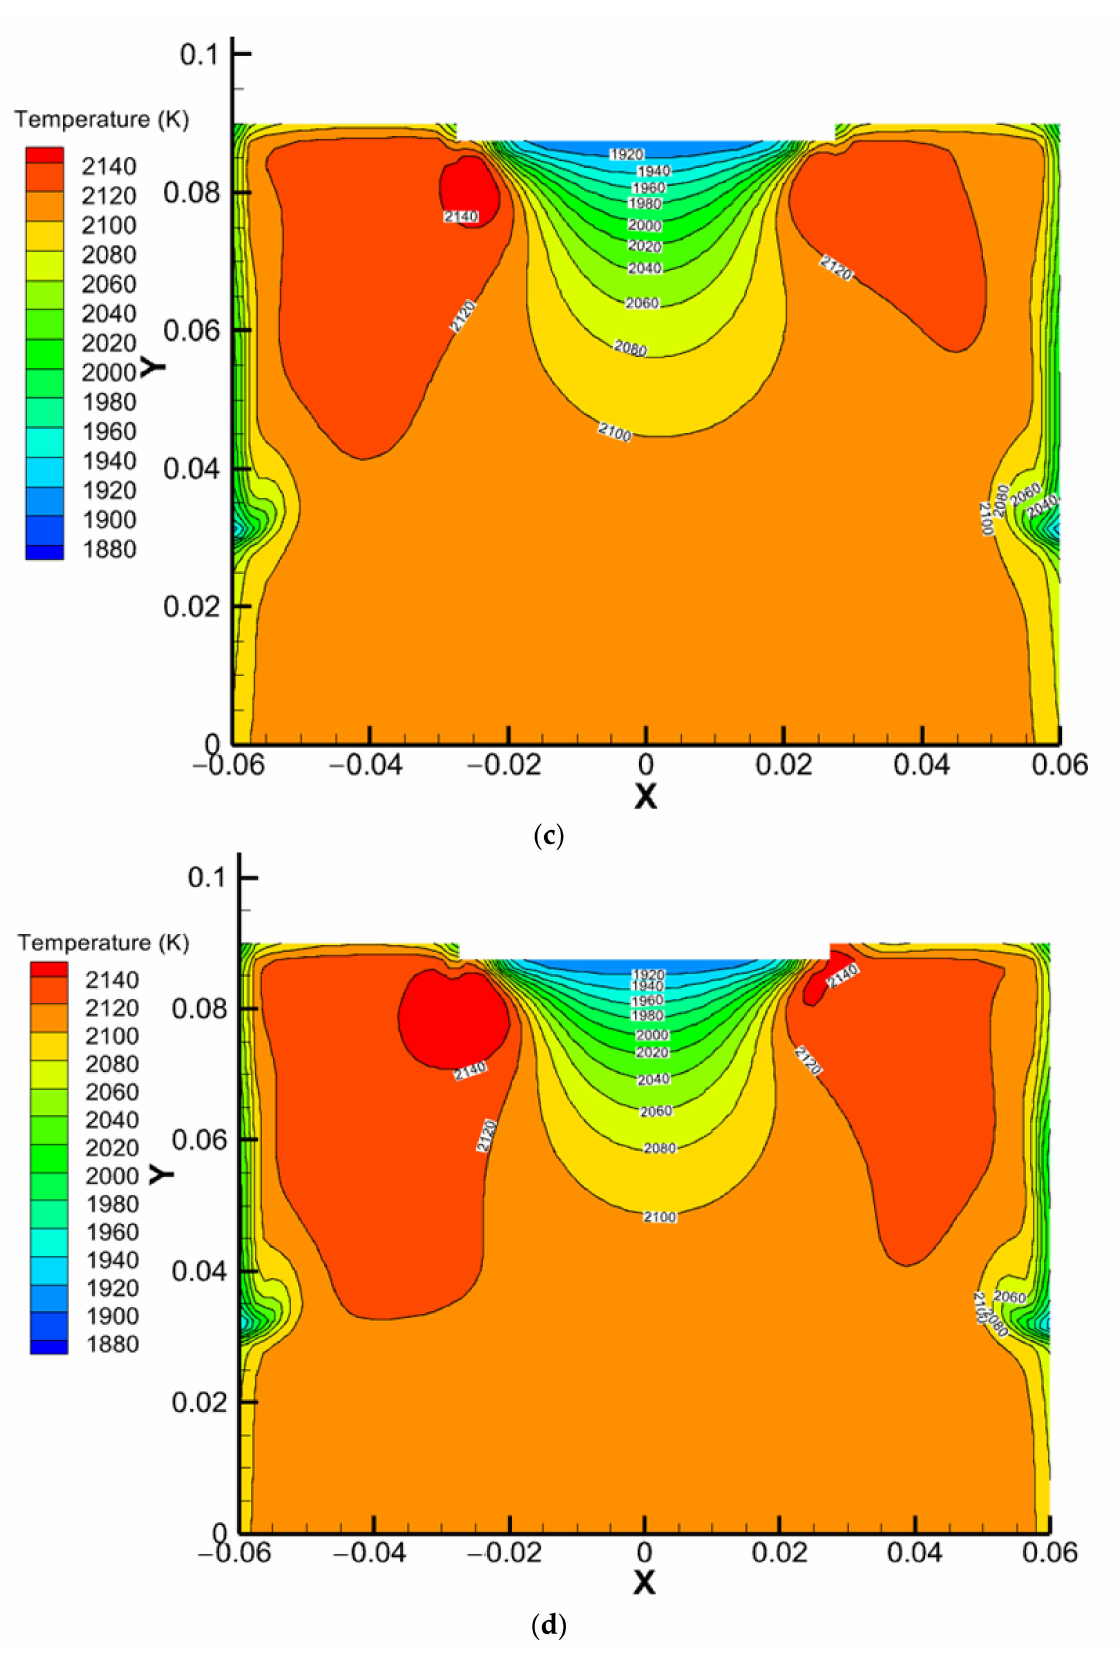
Figure 2. Temperature-field distribution with ( a ) vibrating electrode (t = 10 s) ( b ) conventional electrode (t = 10 s) ( c ) current of 1800 A in the ESR process with vibrating electrode (t = 10 s) ( d ) vibrating electrode (t = 22